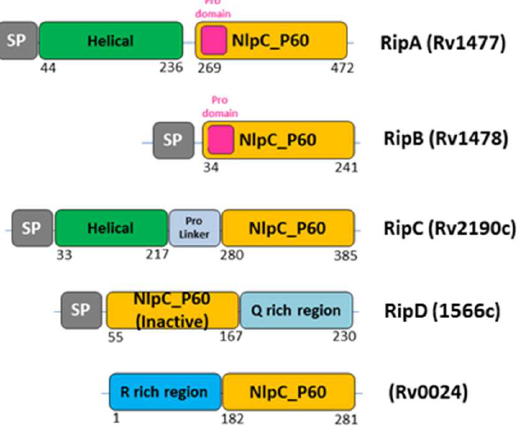
Figure 3. Schematic view of all five NlpC / P60 homologs encoded in the M. tuberculosis genome.